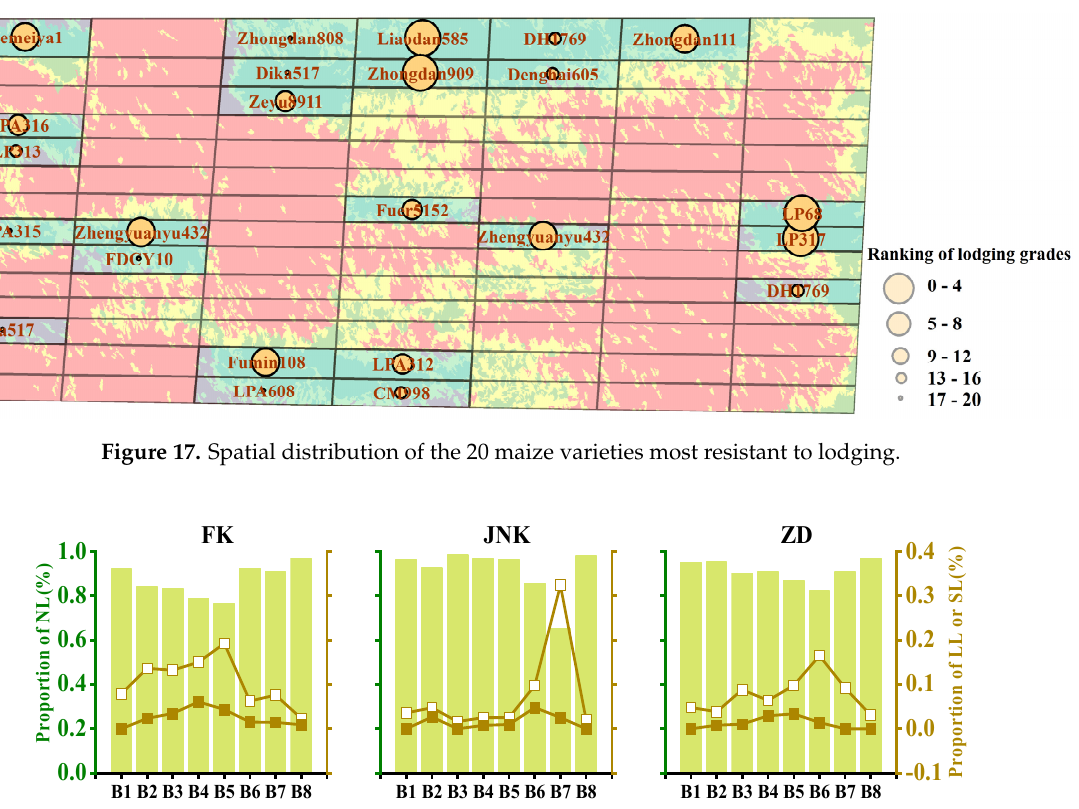
Figure 16. Statistical analysis of degree of lodging of different maize varieties. Note: The fractions of NL, LL, and SL for each maize variety are indicated by green, yellow, and red, respectively. The three varieties most resistant to lodging are Liaodan 585, LP68, and Zhongdan909, respectively.